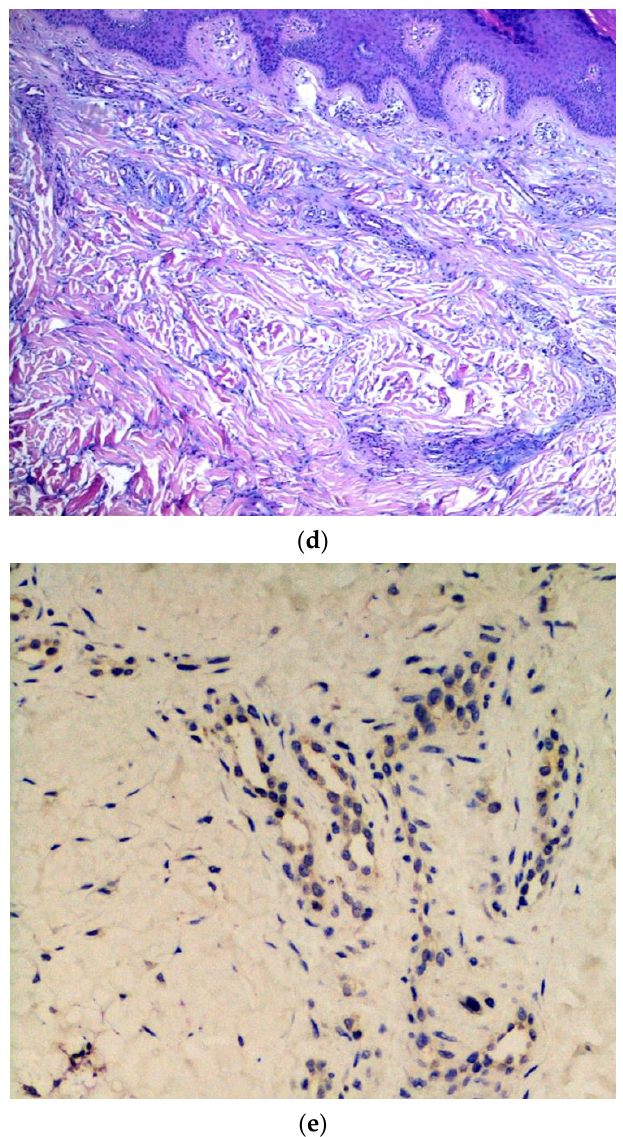
Figure 1. ( a ) Example of a skin rash with polymorphic erythema characteristics affecting the chest, arms and hands. Erythematous patches with irregular, polycyclic contours. ( b ) Detail of the erythema on the forearm. ( c ) Detail of the erythema on the hand. ( d ) Histopathological findings of erythema-multiforme-like lesions. Note the perivascular lymphocytic infiltrate and focal dermal mucinosis (hematoxylin and eosin (H&E), original magnification 100×). I Details of a SARS-CoV-2 spike protein in endothelial cells from erythema-multiforme-like lesions (immunostaining for SARS-CoV-2 spike proteins, original magnification 400×).